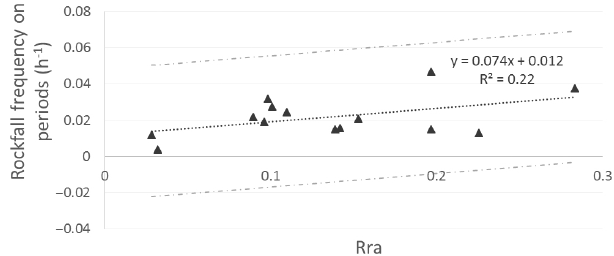
Figure 8. Simple linear regression between rainfall amount ratio (Rra) and rockfall frequency for dating periods without freeze– thaw. Dashed grey lines: 95% interval